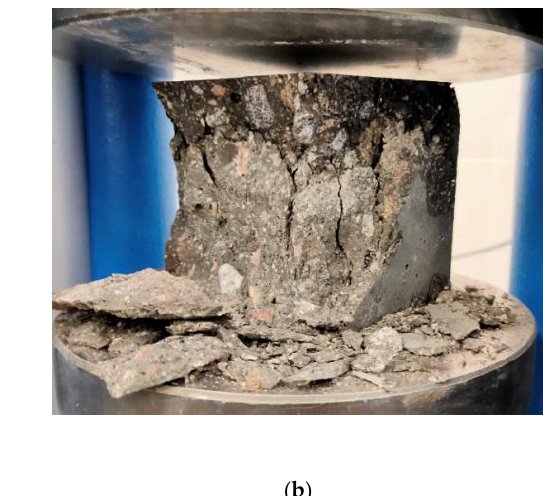
Figure 13. Compression Strength Failure Shapes: ( a ) Basalt Fiber reinforced High-Performance Concrete PC; ( b ) High-Performance Concrete.